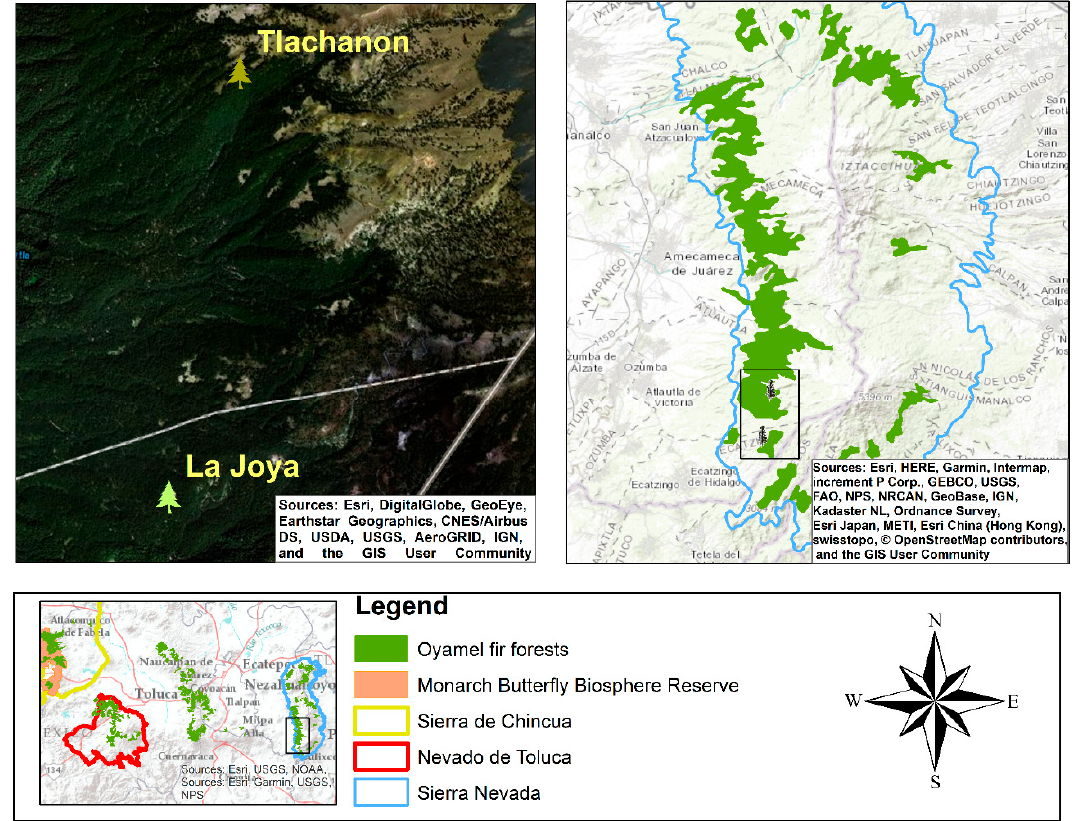
Figure 4. Locations of the La Joya and Tlachanon sites in the Sierra Nevada Region.